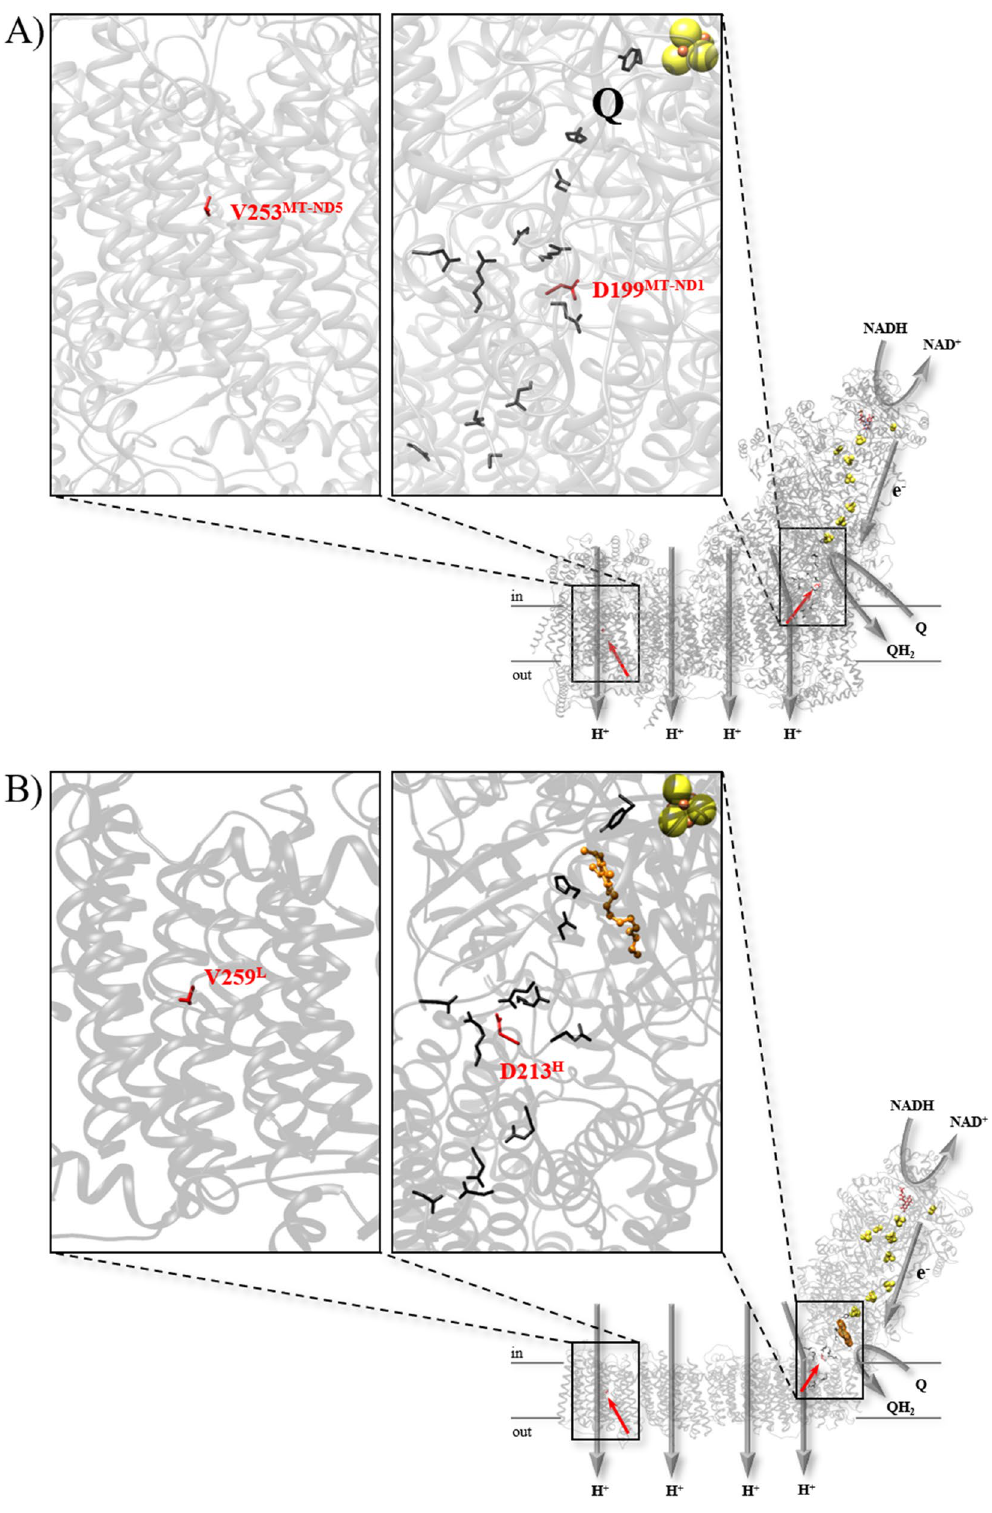
Figure 1. Structure of complex I from human ( A ) and from T. thermophilus ( B ) (PDB: 5XTD 81 and 6I0D 82 ) . For simplicity, subunits and residues of the bacterial complex are named according to the E. coli nomenclature. The positions of the mutations are shown in red; a close-up of the positions environment is shown in the insets. Residues of the area of charged amino acids around D199 MT-ND1 /D213 H and of the E-channel are shown in the right inset. Putative proton pathways are indicated with gray arrows, as well as NADH and quinone binding